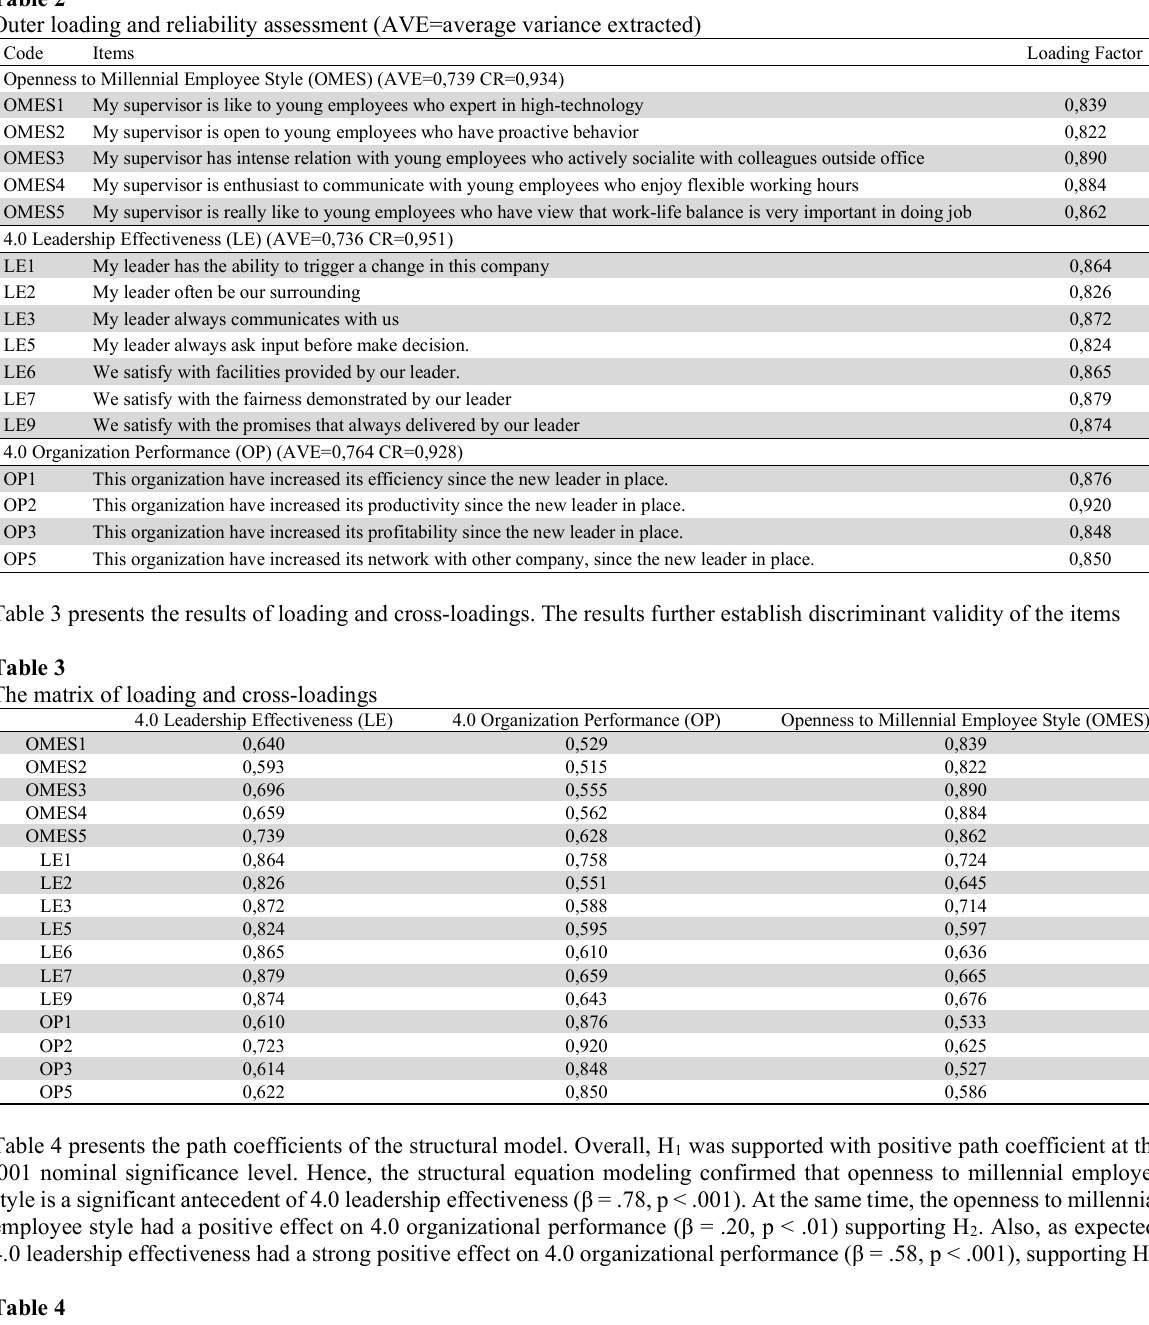
A Summary of Path Results (N = 224)